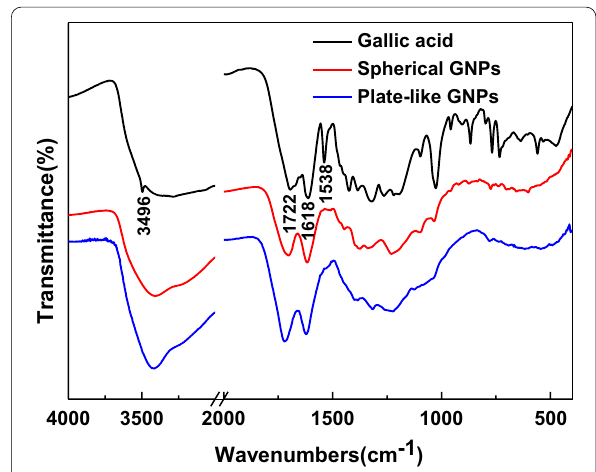
Fig. 3 FTIR spectra of gallic acid, spherical and plate-like GNPs